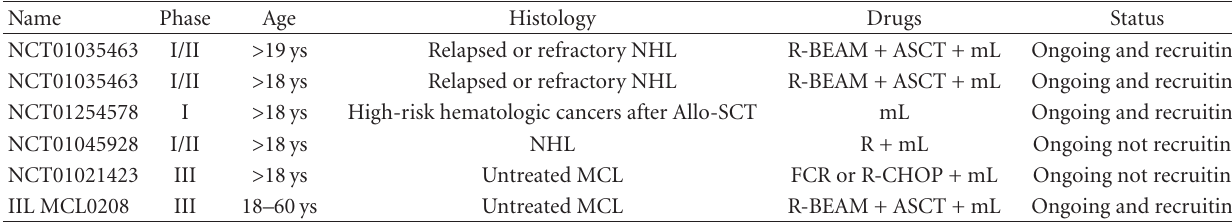
Table 7: Ongoing lenalidomide-maintenance